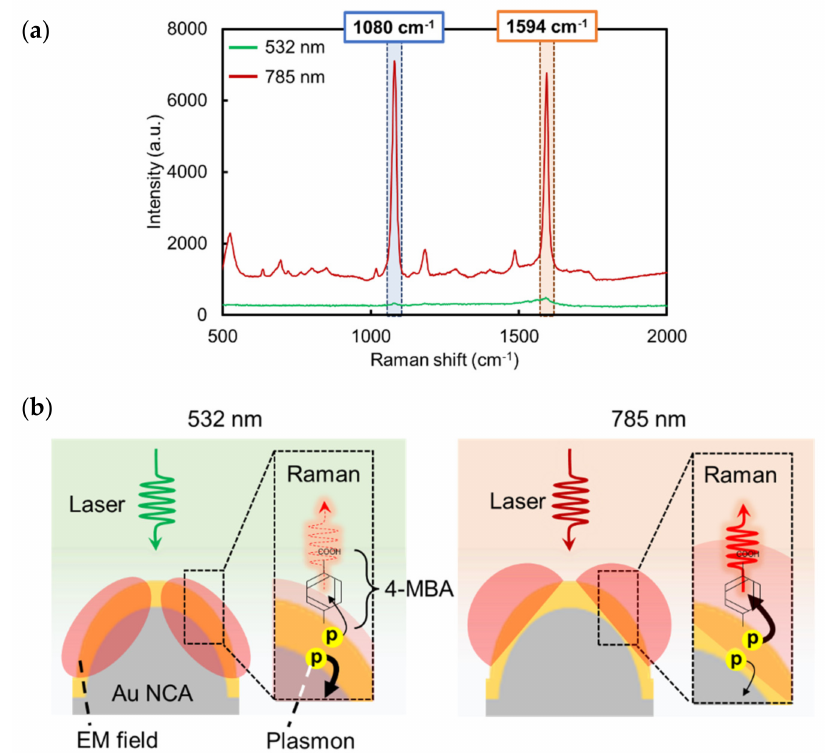
Figure 4. ( a ) Raman spectra of 10 − 3 M 4-MBA on Au NCA (Au thickness of 50 nm) excited by a 532 or 785 nm laser. ( b ) Illustrations of EM field distributions of Au NCA excited by 532 or 785